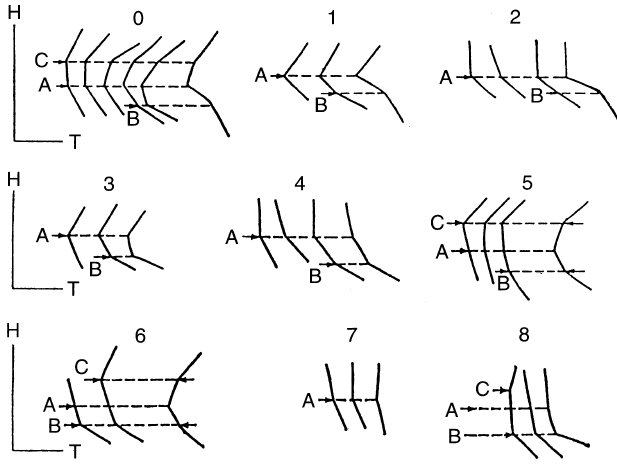
Fig. 1. Tropopause types and change of vertical temperature gradient within the tropopause (A – tropopause level, B and C – lower and upper